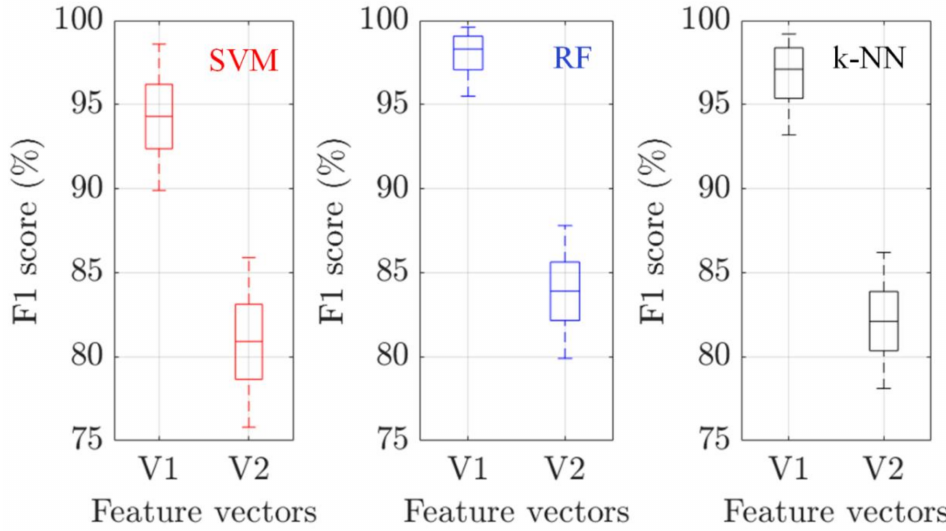
Figure 5. Statistical boxplot of the F1 score for the three ML classifiers.